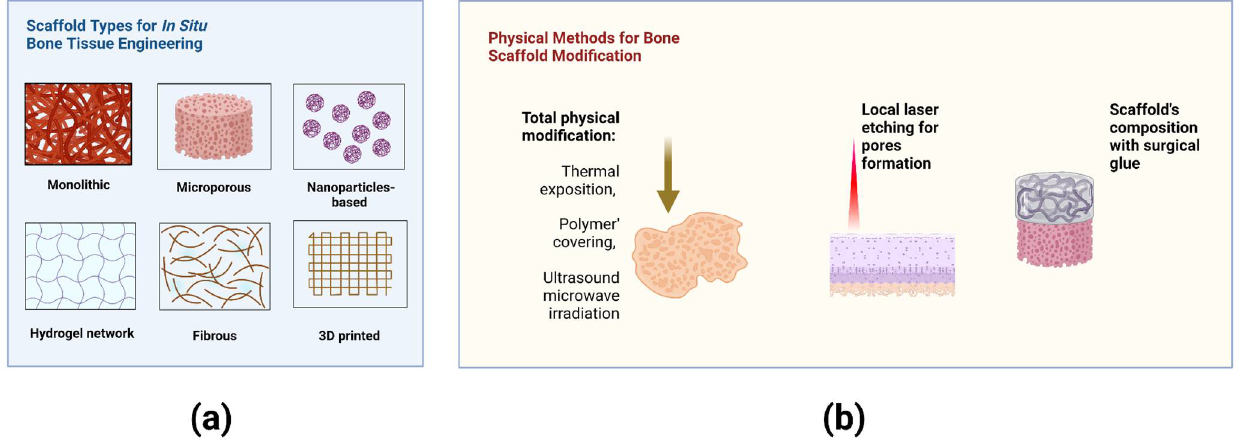
Figure 2. ( a ) Scaffold types for bone tissue engineering in situ. ( b ) Methods for physical modification of scaffolds immediately in the Operating Room. Created with